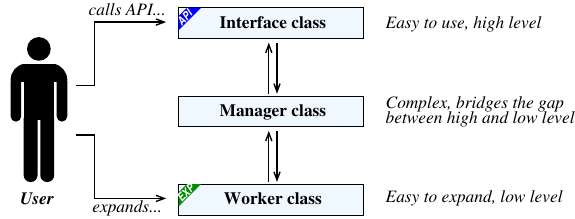
Figure 2. Manager/worker architecture; very often the interface and the manager are implemented in the same class, the interface being the public interface and the manager being the private implementa-